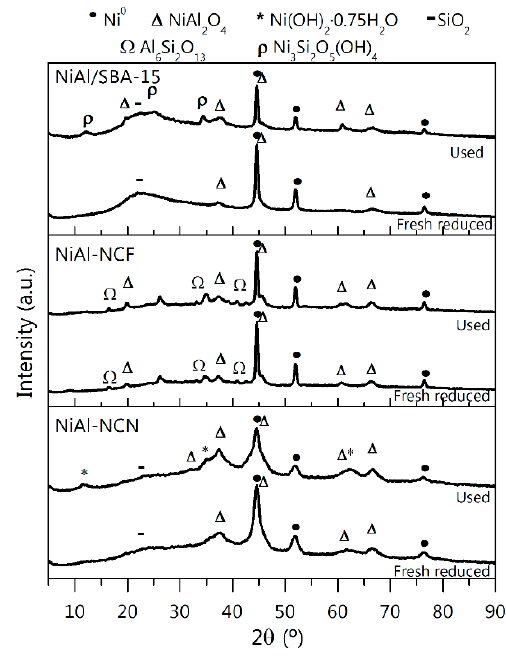
Figure 9. XRD of spent